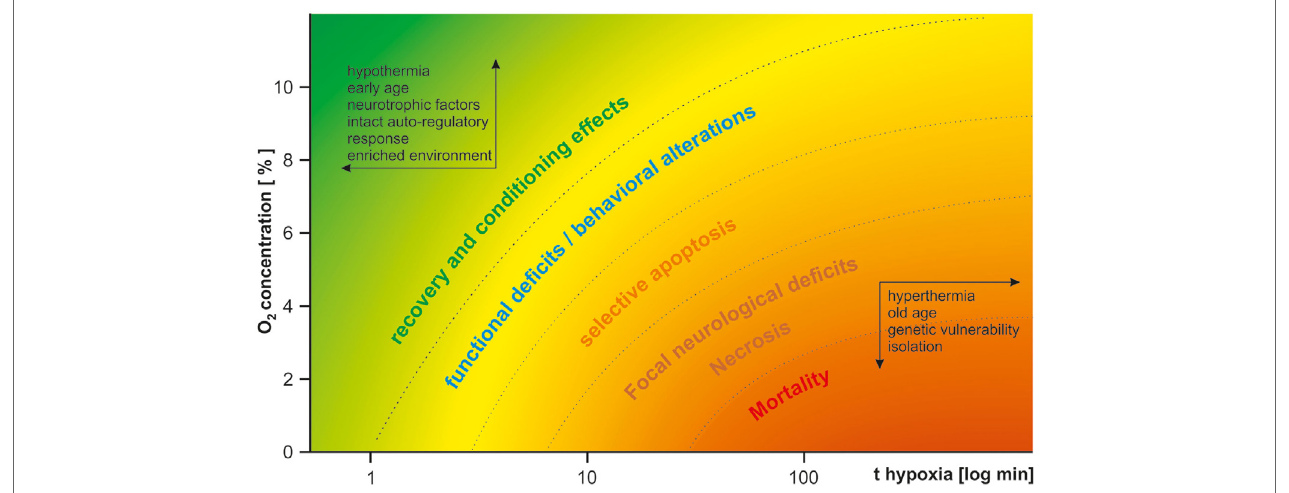
FigUre 1 | Qualitative effects of hypoxia in dependence of severity and duration of the insult. The insult duration is drawn logarithmically on the x -axis. The oxygen concentration is drawn on the y -axis. Depending on both parameters, the insult either lacks long-lasting effects or is even protective (upper-left corner, green), or leads to functional and structural deficits (from yellow to orange) and mortality (bottom-right corner, red). Protective factors are listed within the arrows in the upper-left corner; harmful factors are listed within the arrows in the bottom-right corner. For psychiatric research, a mild type of insult in the yellow range needs to be carefully